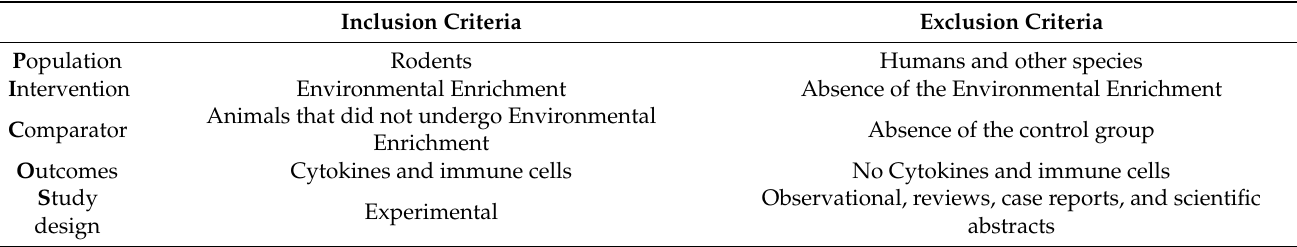
Table 2. Eligibility criteria based on the PICOS strategy.